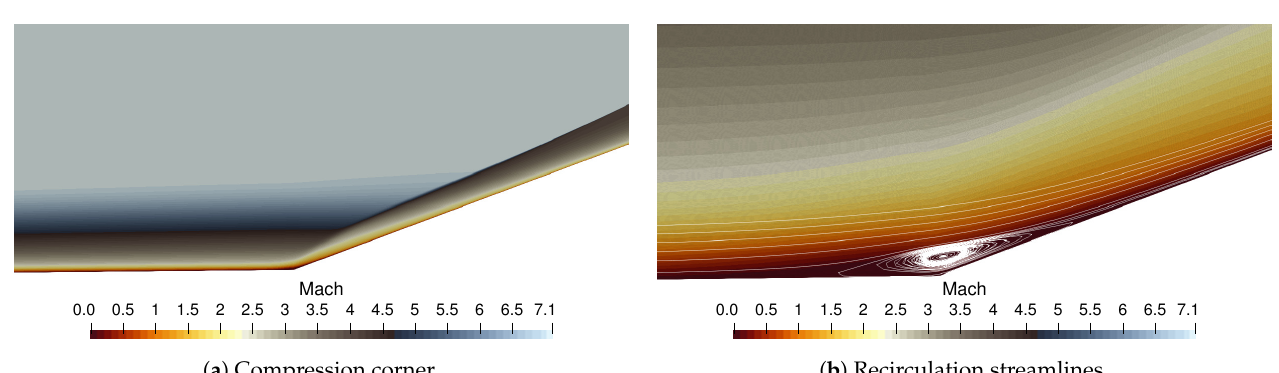
Figure 11. ASWBLI Mach contours over the compression